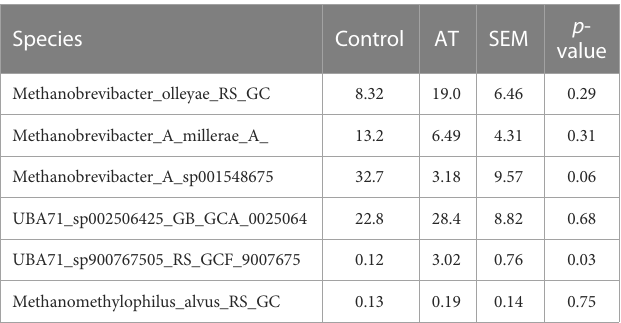
TABLE 7 Mean abundance of archaeal species for cows with a diet without (control) or with supplementation with Asparagopsis taxiformis